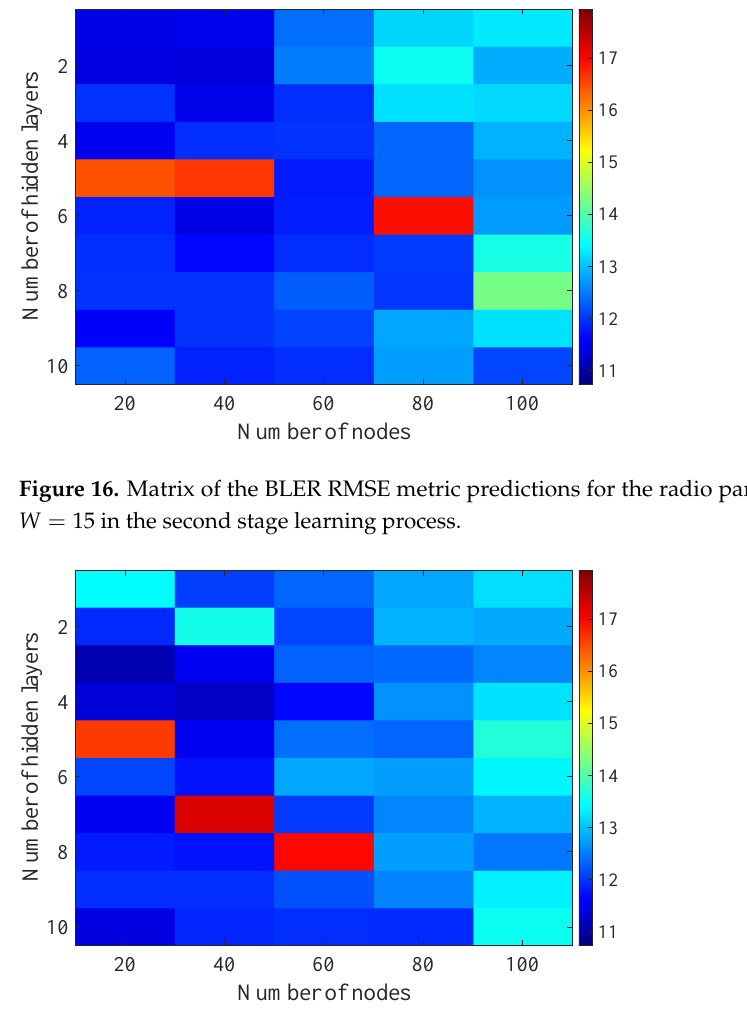
Figure 17. Matrix of the BLER RMSE metric predictions for the radio parameters history window W = 20 in the second stage learning